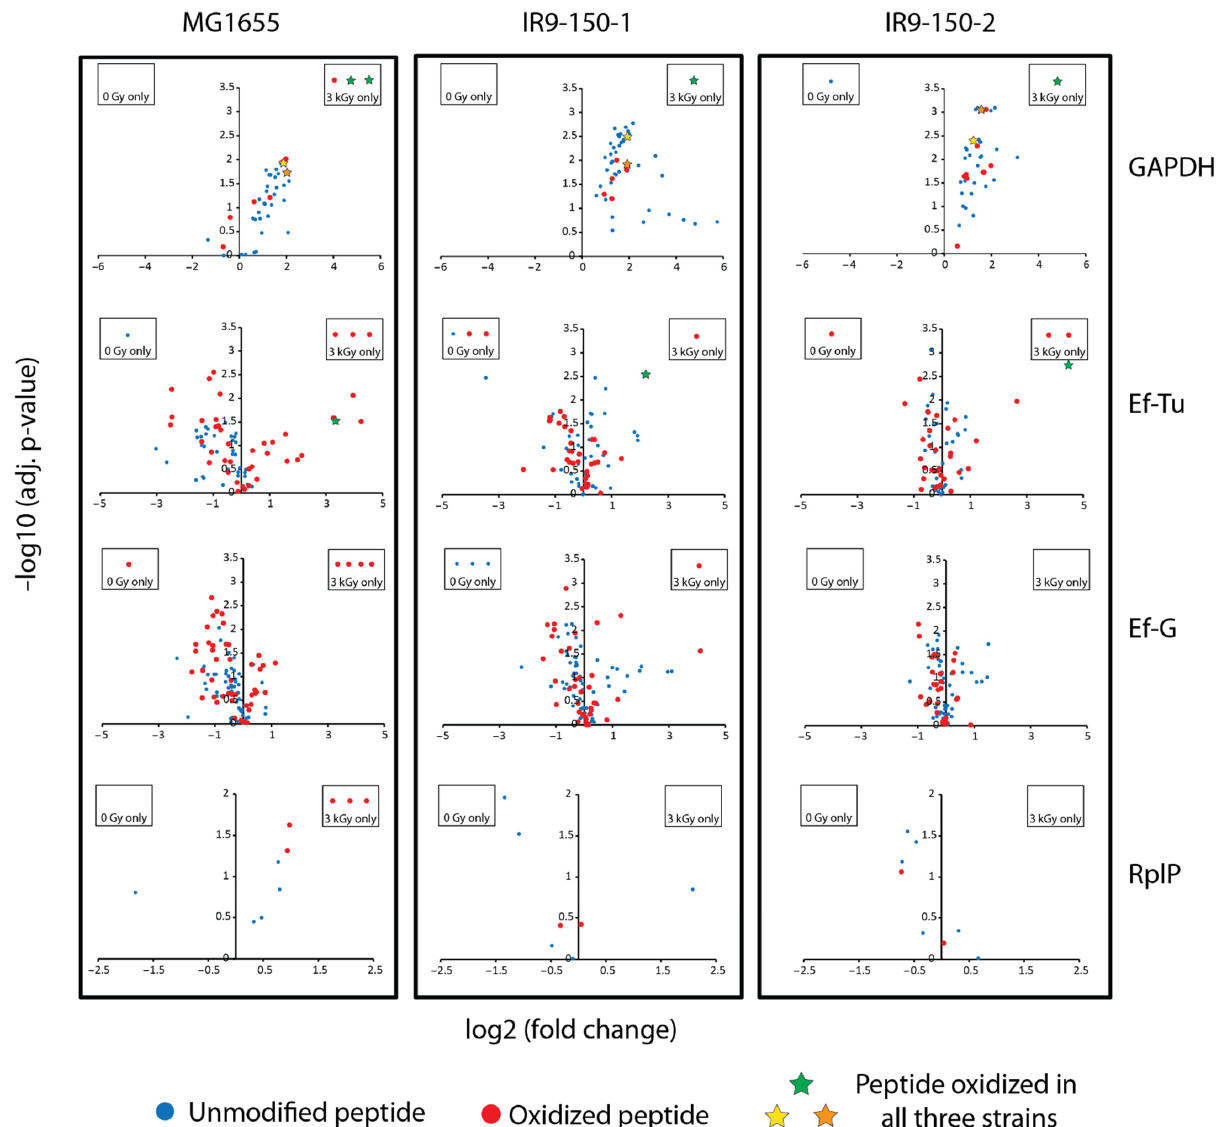
Figure 3. Oxidation of glyceraldehyde 3-phosphate dehydrogenase (GAPDH), elongation factor (Ef)-Tu, Ef-G, and RplP across all three E. coli isolates. Volcano plots depict the fold increase or decrease (log2 transformed) and statistical significance of the fold change ( − log10 transformed Benjamini–Hochburg adjusted p -value). Peptides that were only detected in the 3 kGy irradiated samples are shown in a separate box associated with the appropriate volcano plot. Each dot represents a single peptide, where unmodified peptides are blue, oxidized peptides are red, and modified peptides with a significant fold increase (fold change greater than 2, adjusted p -value less than 0.05) detected in all three E. coli isolates are depicted as stars. The color of the star denotes the same peptide across the three isolates. For GAPDH, a green star indicates an oxidized active site peptide (YAGQDIVSNASCTTNCLAPLAK), and orange and yellow stars indicate two other oxidized proteins elsewhere in GAPDH (DNTPMFVK and LTGMAFR). For Ef-Tu, the green star indicates an oxidation on the peptide AFDQIDNAPEEK.